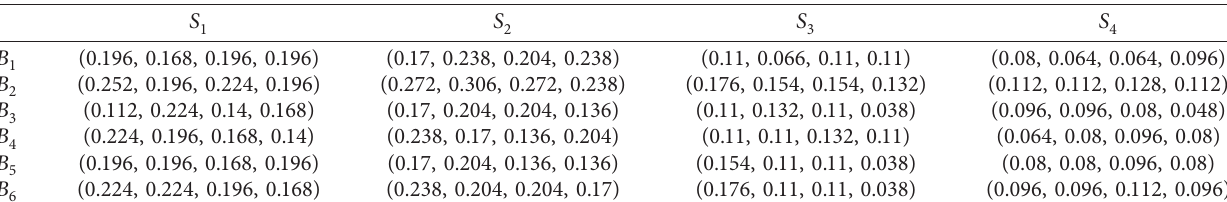
Table 3: 4F weighted decision matrix.